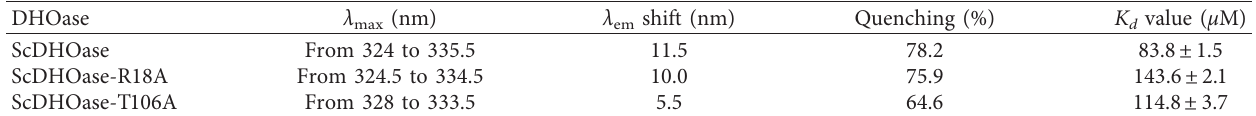
Figure 5: Fluorescence titration of ScDHOase with 5-FOA. (a) The fluorescence emission spectra of ScDHOase with 5-FOA of different concentrations (0–200 μ M; 0, 10, 20, 50, 75, 100, 125, 150, 175, and 200 μ M). The decrease in intrinsic fluorescence of protein was measured at 324 nm upon excitation at 280nm with a spectrofluorimeter. The fluorescence intensity emission spectra of ScDHOase significantly quenched with 5-FOA. (b) The fluorescence emission spectra of ScDHOase-R18A with 5-FOA of different concentrations (0–200 μ M). (c) The fluorescence emission spectra of ScDHOase-T106A with 5-FOA of different concentrations (0–200 μ M). ScDHOase-R18A and ScDHOase-T106A individually displayed strong intrinsic fluorescence with a peak wavelength of 324.5 and 328nm when excited at 280nm. (d) An aliquot amount of 5-FOA was added to the enzyme solution for determining K d . K d was obtained by the following equation: Table 2: Binding parameters of ScDHOase to